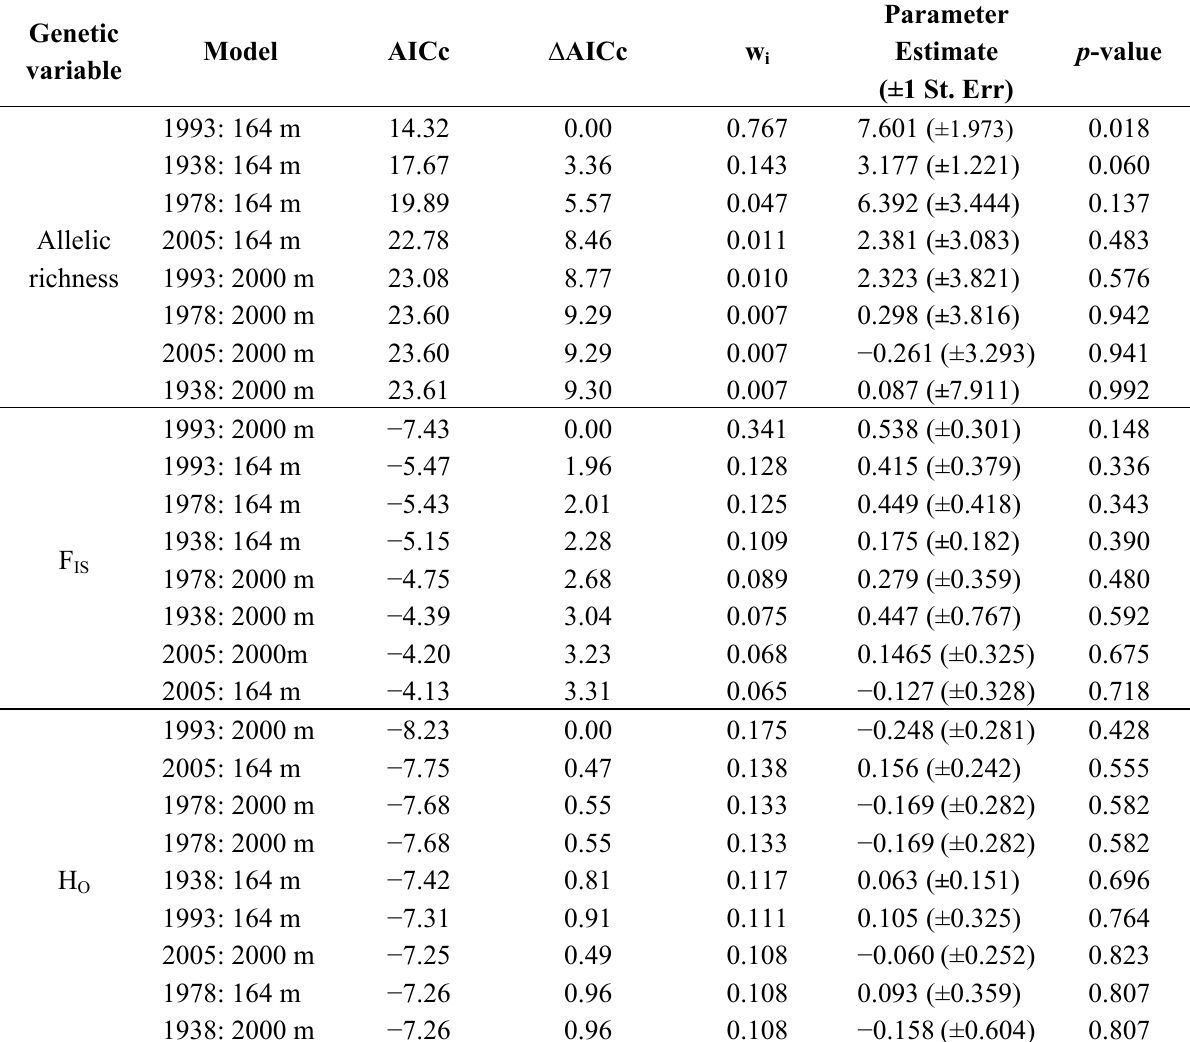
Table 2. Akaike’s Information Criterion of candidate models that examine habitat availability and time on genetic variables (F H = expected E